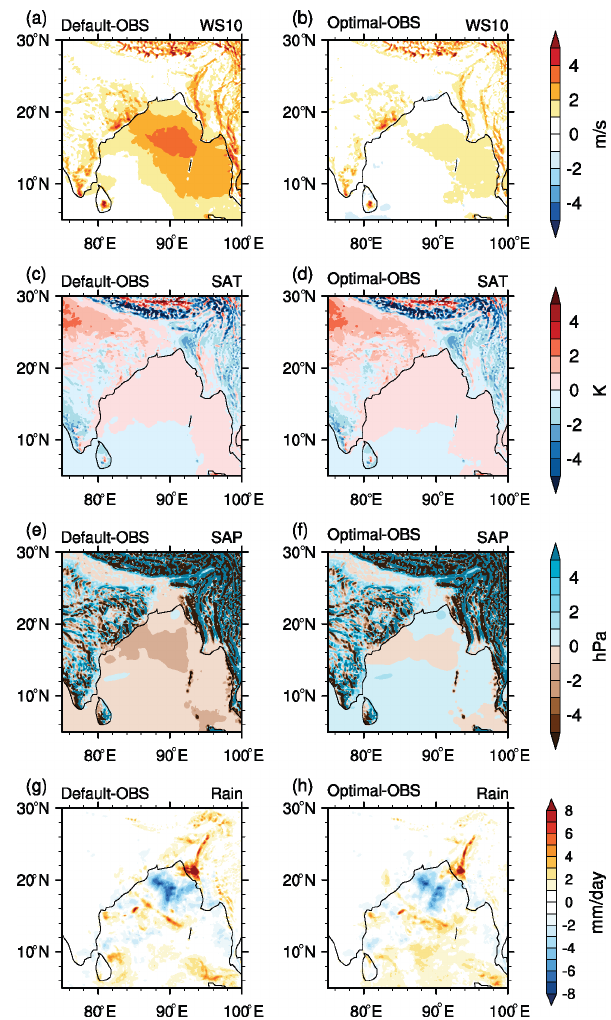
Figure 15. Comparison of the spatial distribution of meteorological variables simulated using default and optimal parameters, averaged over all the cyclones for 3.5d. Surface wind bias (ms − 1 ) (a) be- tween default and observations, (b) between optimal and observa- tions, (c, d) surface temperature bias (K), (e, f) surface pressure bias (hPa), and (g, h) precipitation bias (mmd − 1